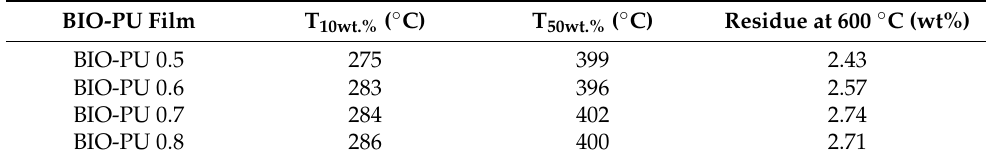
Table 3. Thermal degradation stability of BIO-PU films.